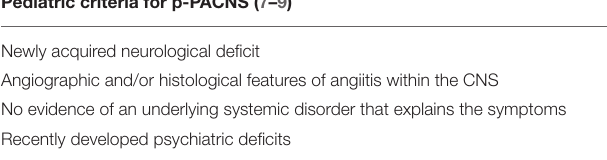
TABLE 1 | Criteria for p-cPACNS. Pediatric criteria for p-PACNS (7–9) Newly acquired neurological